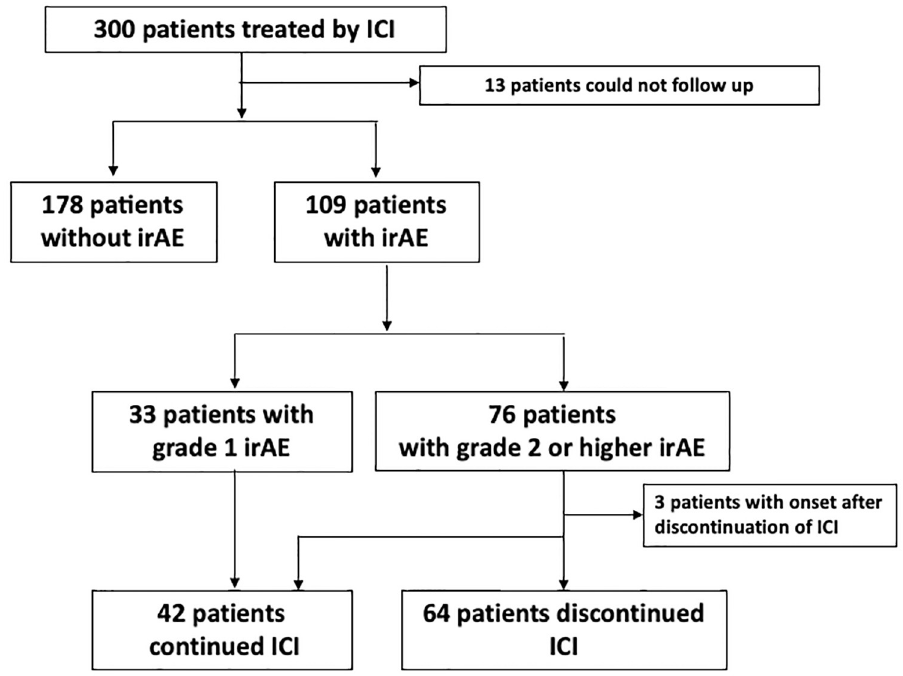
Fig 1. Participants in this study. ICI: immune checkpoint inhibitors, irAE: immune-related adverse event.